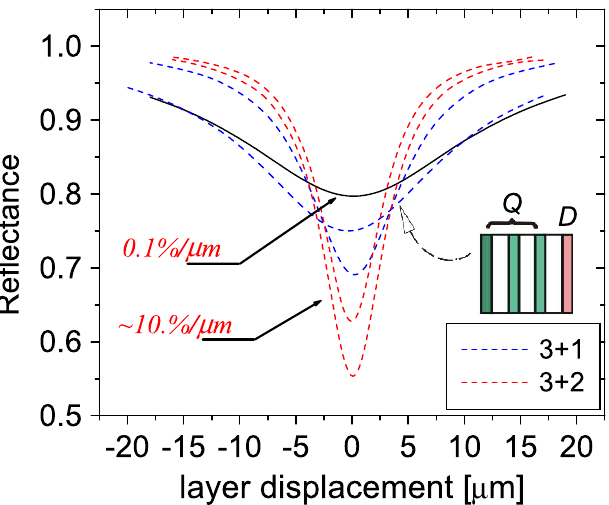
FIG. 8. (Color) Refractive index variation provides a large tun- ing range for setting the amplitude of the reflectivity dip at the vicinity of any THz-FEL outcoupling ratio of practical rele- vance. The solid curve refers to the ‘‘all quartz 3 þ 1 ’’